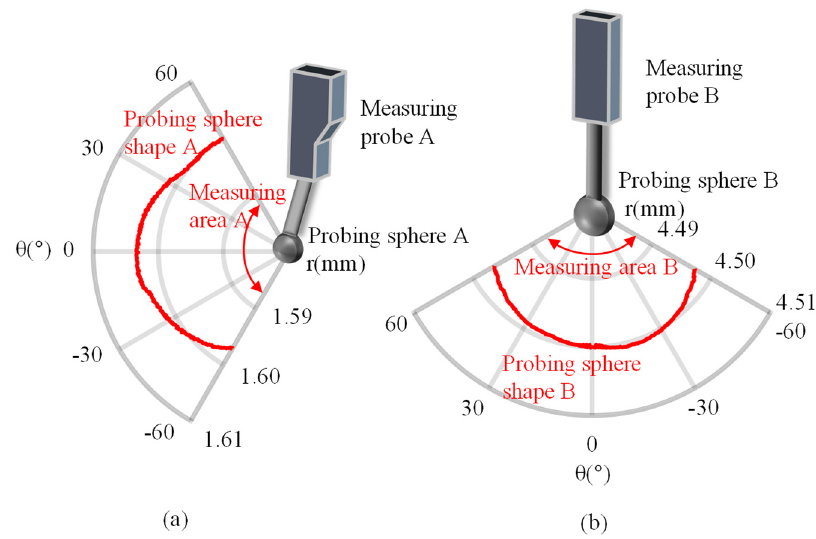
Figure 13. Experimental results of the tilt alignments of the lateral and axial displacement gauges. ( a ) Tilt alignment of the lateral displacement gauge (probe A); ( b ) tilt alignment of the axial displace- ment gauge (probe B).